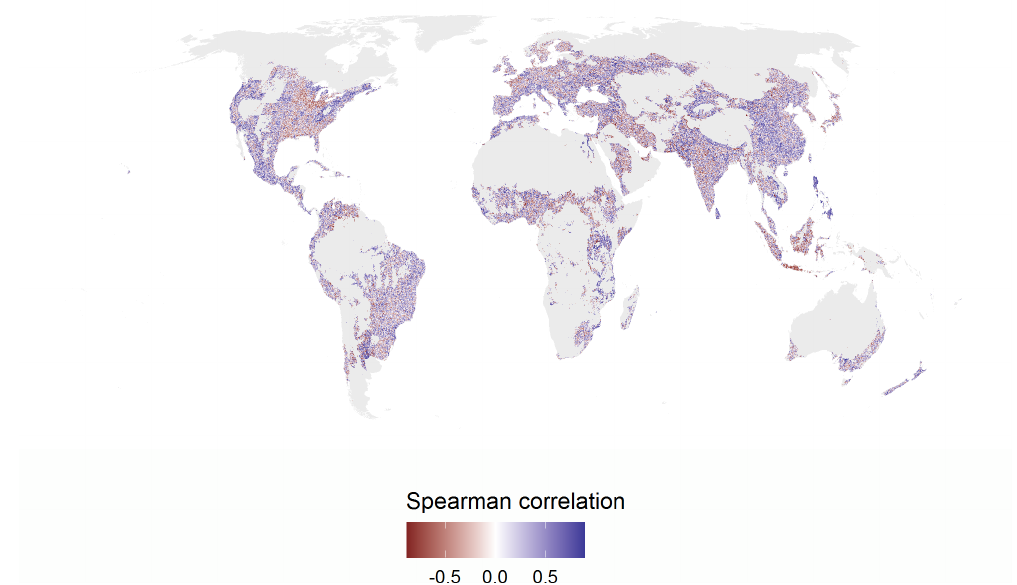
Figure 8. Spearman correlation in areas of AgGDP above or equal to 200000 in the cross-entropy and rural per capita models.